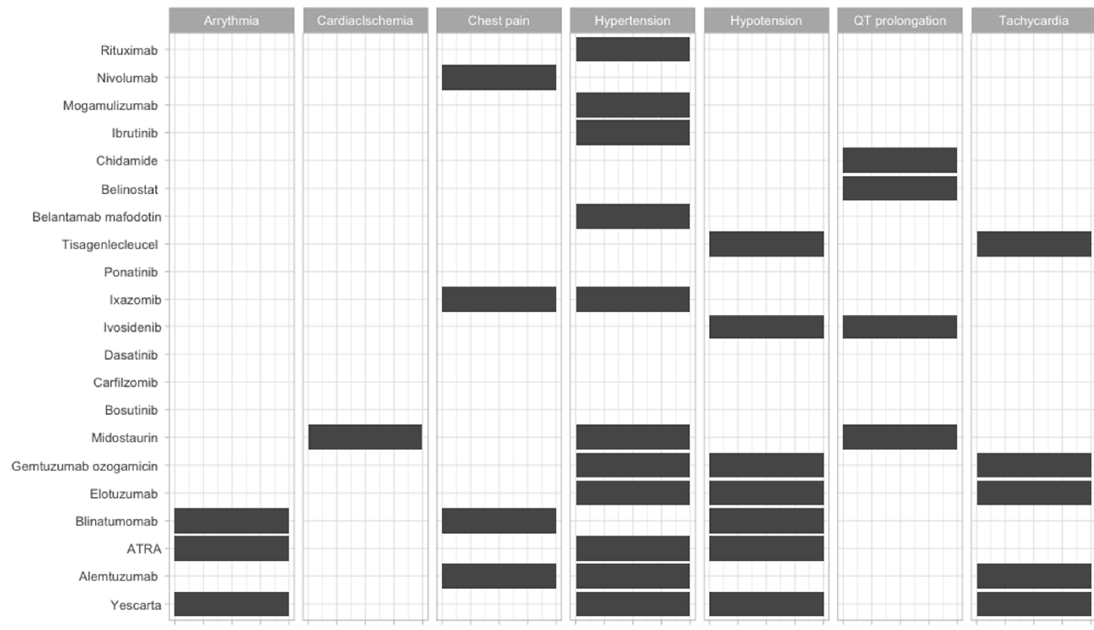
Figure 2. Cardiac side-effects of Food and Drug Administration (FDA)-approved and non-approved drugs for hematological disorders.